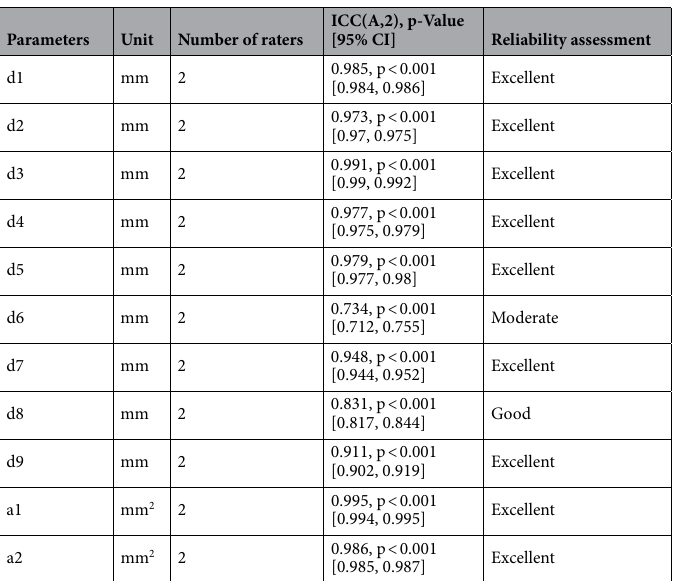
Table 2. Intraclass Correlation (ICC) calculations as a measure of inter-rater reliability of the measurements made based on MRIs. Presented ICC values are the average score ICCs calculated based on the one-way random model. CI 95% confidence interval for ICC